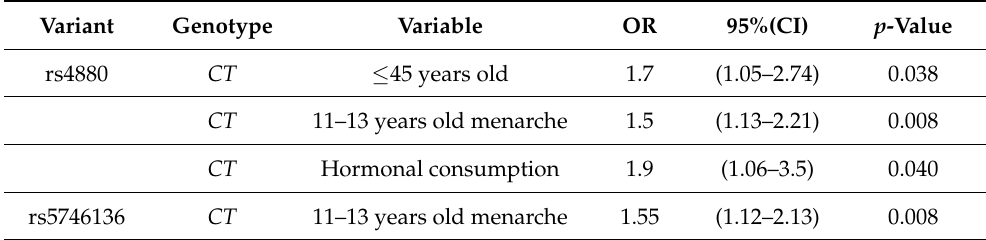
Table 4. Association of the rs4880, and rs5746136 variants of SOD2 with age, menarche age, and hormonal consumption in the BC patients and the controls.